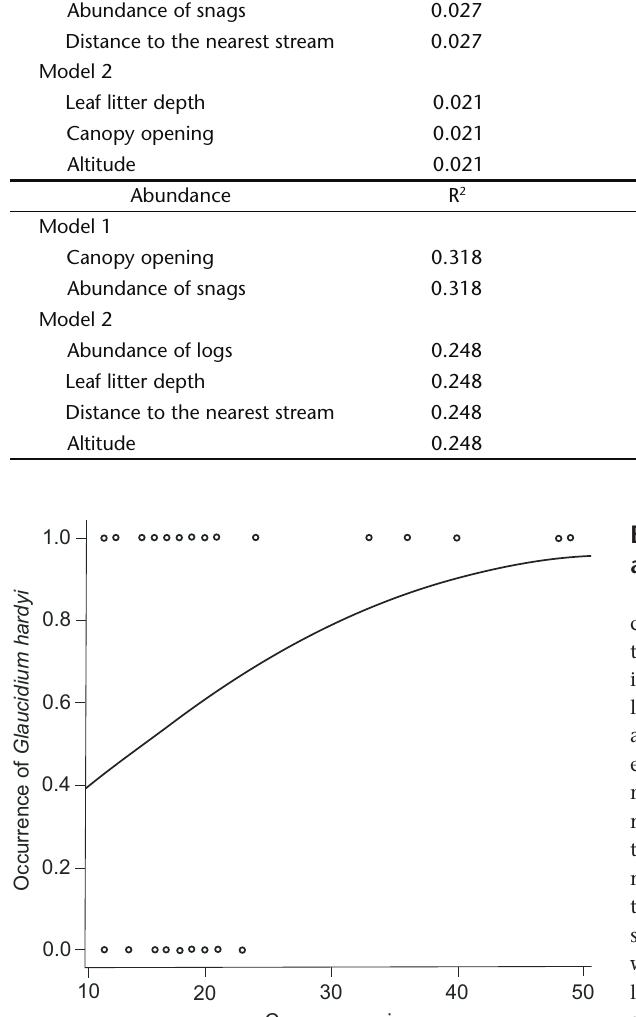
Figure 6. Descriptive curve generated by the logistic regression showing the relationship between G. hardyi occurrence and canopy opening (the results corresponds to that in table VI).